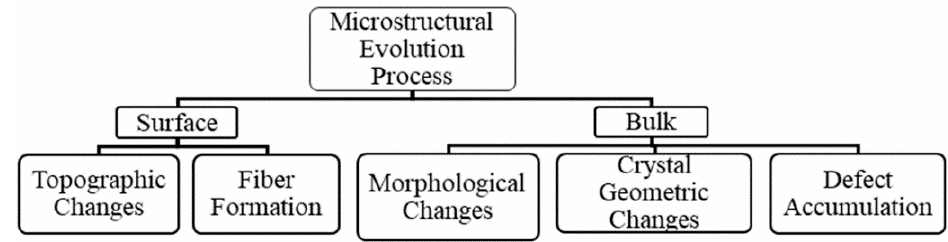
Figure 13. Dependence of the microstructural evolution process on different factors.